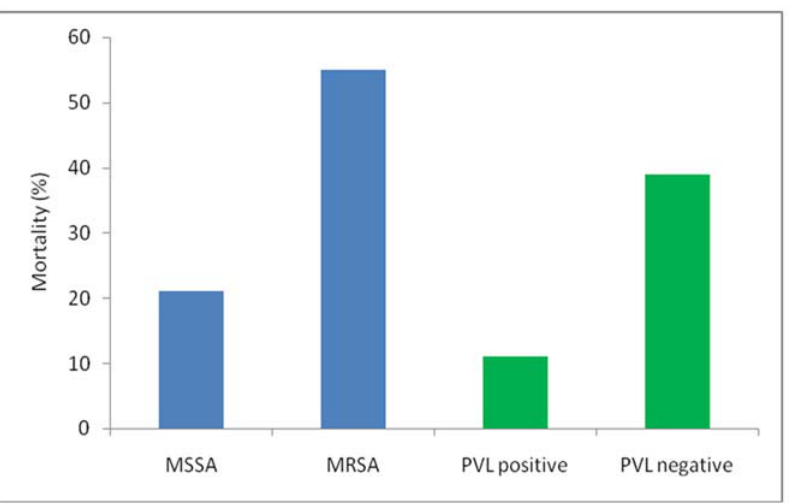
Figure 1. Higher all-cause mortality associated with methicillin-resistant S.aureus (MRSA) but not with Panton-Valentine Leukocidin (PVL). Patients infected by MRSA had a greater all-cause mortality compared with patients infected by methicillin-susceptible S. aureus (MSSA) (p , 0.001). Conversely, patients infected by PVL gene-positive S. aureus had a lower all-cause mortality compared with patients infected by PVL gene- negative S. aureus (p , 0.001), an association that remained after adjustment for MRSA (p=0.001).